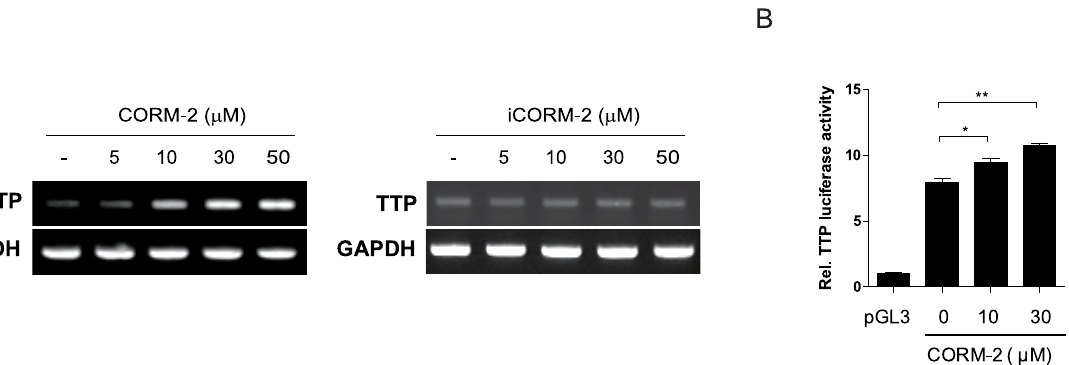
Figure 1. CORM-2 induces TTP promoter activity and TTP mRNA in macrophages. A. RAW264.7 cells were incubated with different concentration of CORM-2 or iCORM-2 for 4 h. TTP mRNA expression was determined by semi-quantitative RT-PCR. B. RAW264.7 cells were transfected with pGL3/mTTP P-1309 containing the mouse TTP promoter. After 24 h, cells were treated with different concentrations of CORM-2 for 4 h, and luciferase activity was determined. The level of firefly luciferase activity was normalized using Renilla luciferase activity. The relative luciferase activity is presented as a fold increase over untreated cells. Values are mean 6 SD (n=3). *, p , 0.05; **, p , 0.01.